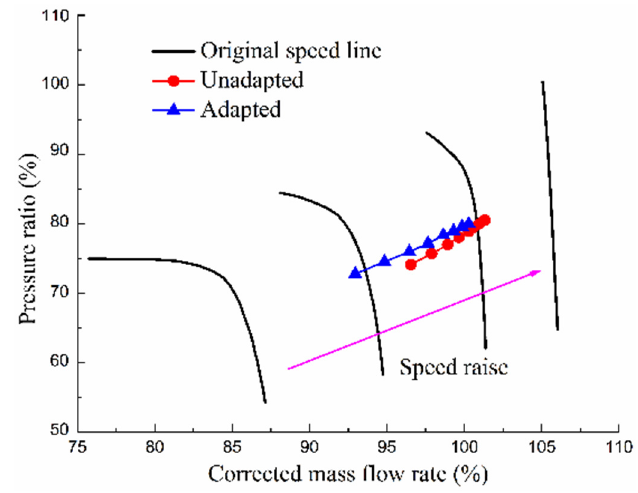
Figure 11. Steady state operating point.